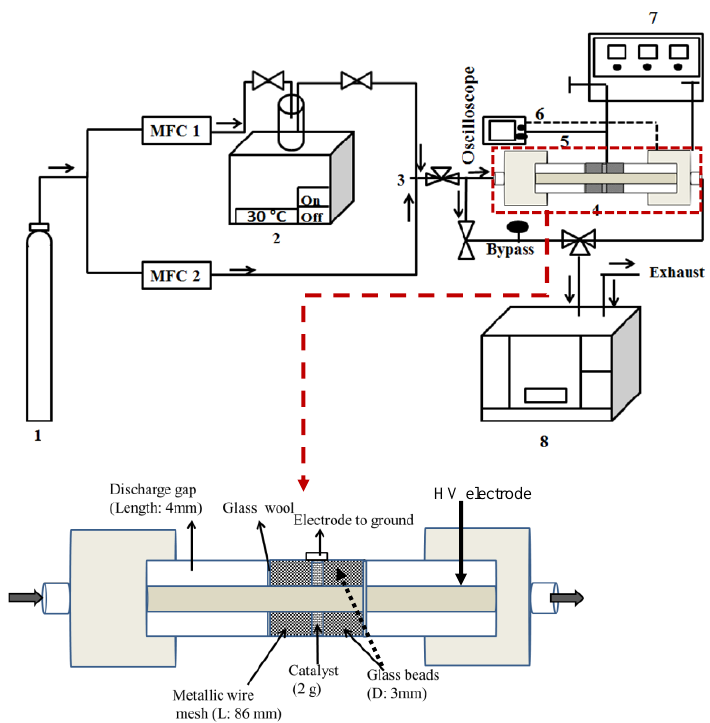
Figure 9. Schematic diagram of the experimental set-up for adsorption and NTP abatement of toluene. 1. Dry air cylinder; 2. Toluene bubbler; 3. Mixing chamber; 4. Packed bed DBD reactor; 5. Resistor (46.4 Ω); 6. High voltage and current probe; 7. AC power source (50 kHz); 8. FT-IR spectrometer.